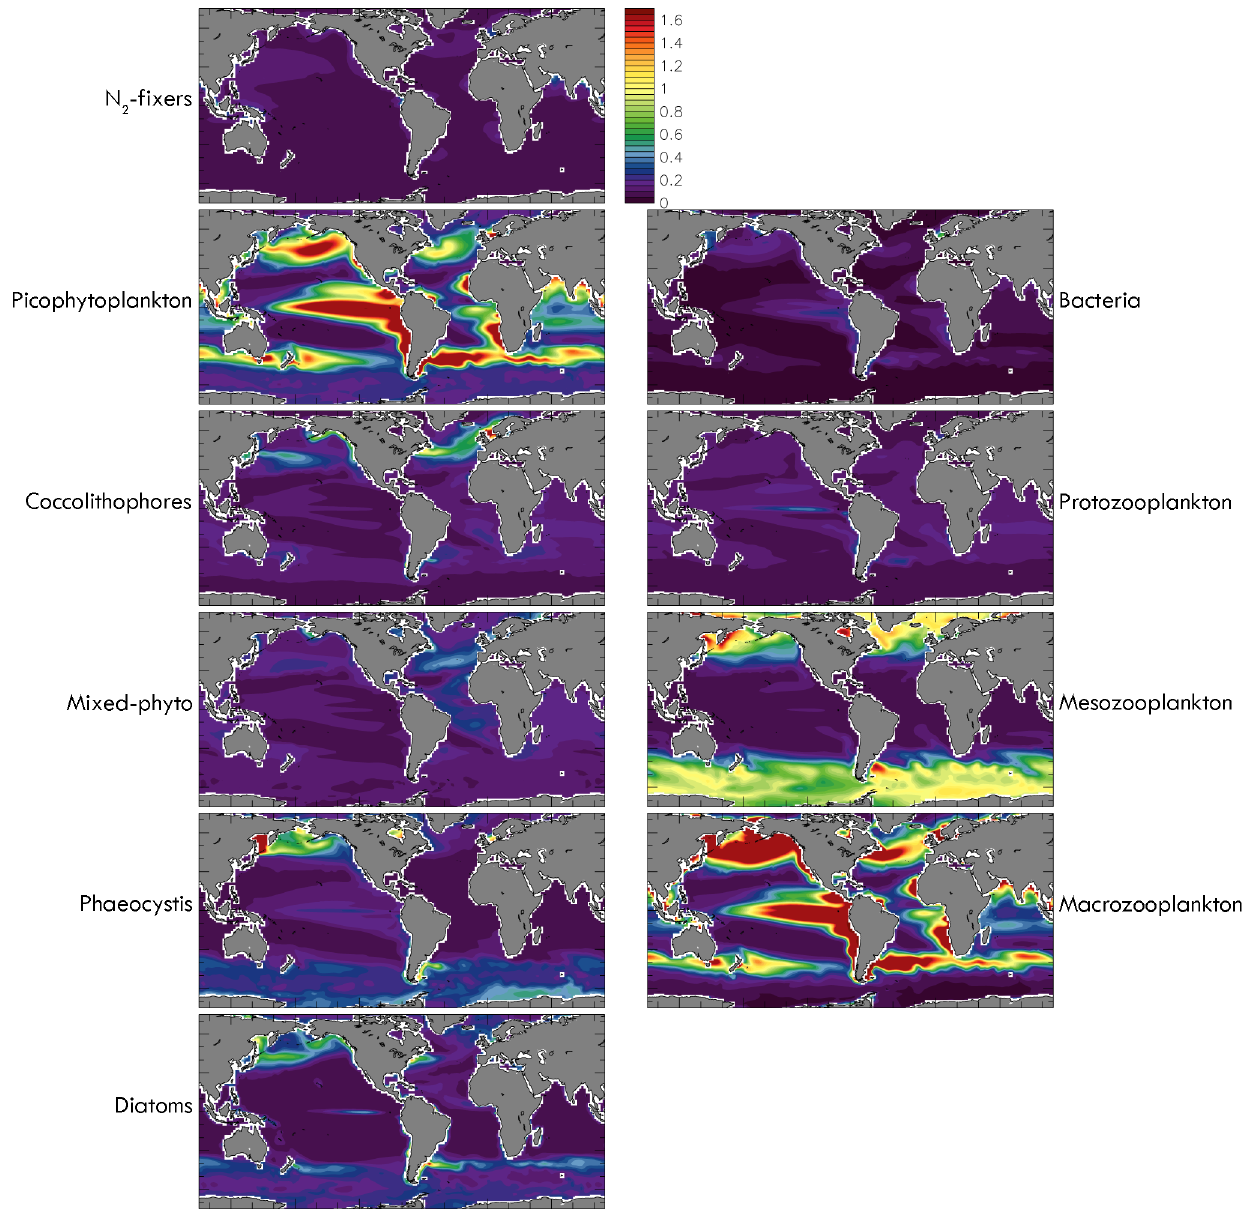
Figure 5. Annual mean surface carbon biomasses for individual plankton functional types as simulated by the PlankTOM10 model (µmolCL − 1 ) . Model results are averaged for 1998–2009 and shown for the top 10m deep surface